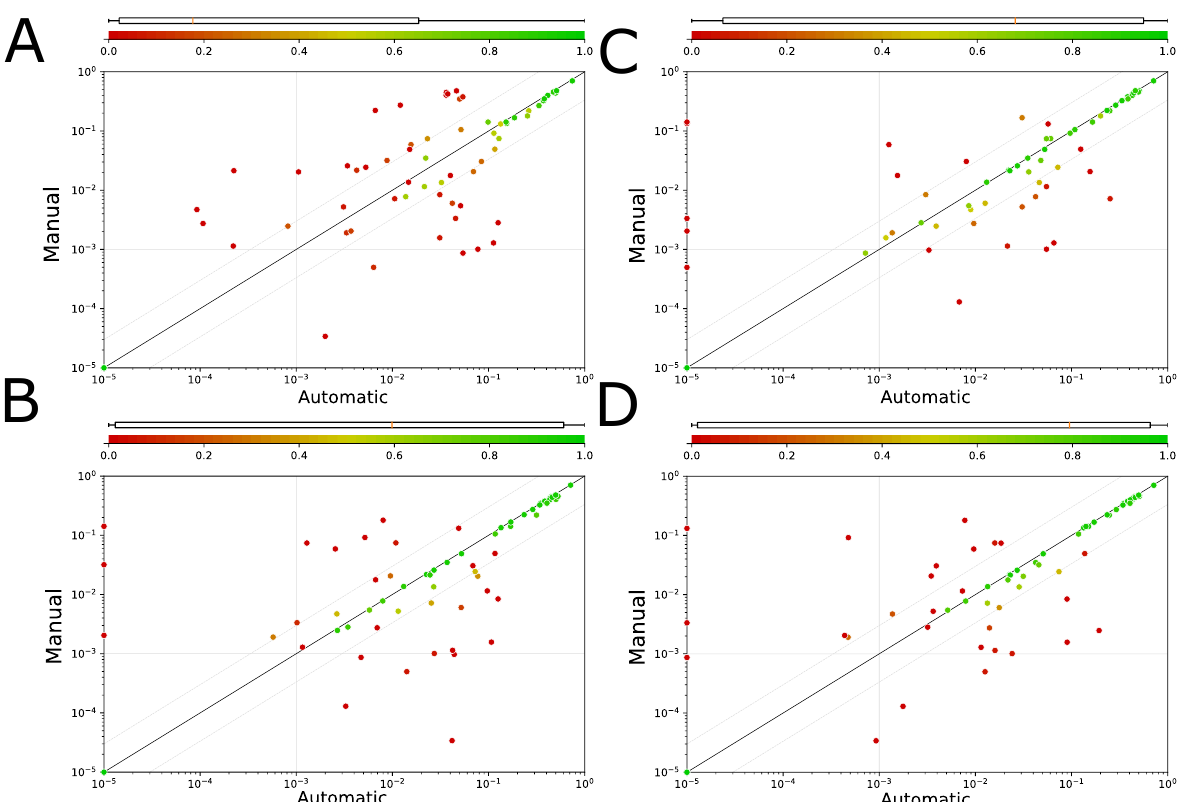
Figure 4. F 1 -scores and predicted MRD values of automatic assessment compared to the manually obtained ground truth. Each dot represents a single sample, the position encodes the MRD values and the color the F 1 -score of a sample. Predictions that are within the range of either less than 3 times or more than 1/3 of the true MRD are considered as acceptable (correct) predictions [22]. These so called concordance margin is visualized as gray lines around the first median. The plots are partitioned into four quadrants by the threshold of 0.1% (thin vertical and horizontal lines), which is the lower clinically relevant resolution. Each plot shows the results of a different experiment using the 8-color tube-specific panels plus drop-ins for CFU samples ( A ): Set-Transformer (Table 1), ( B ):